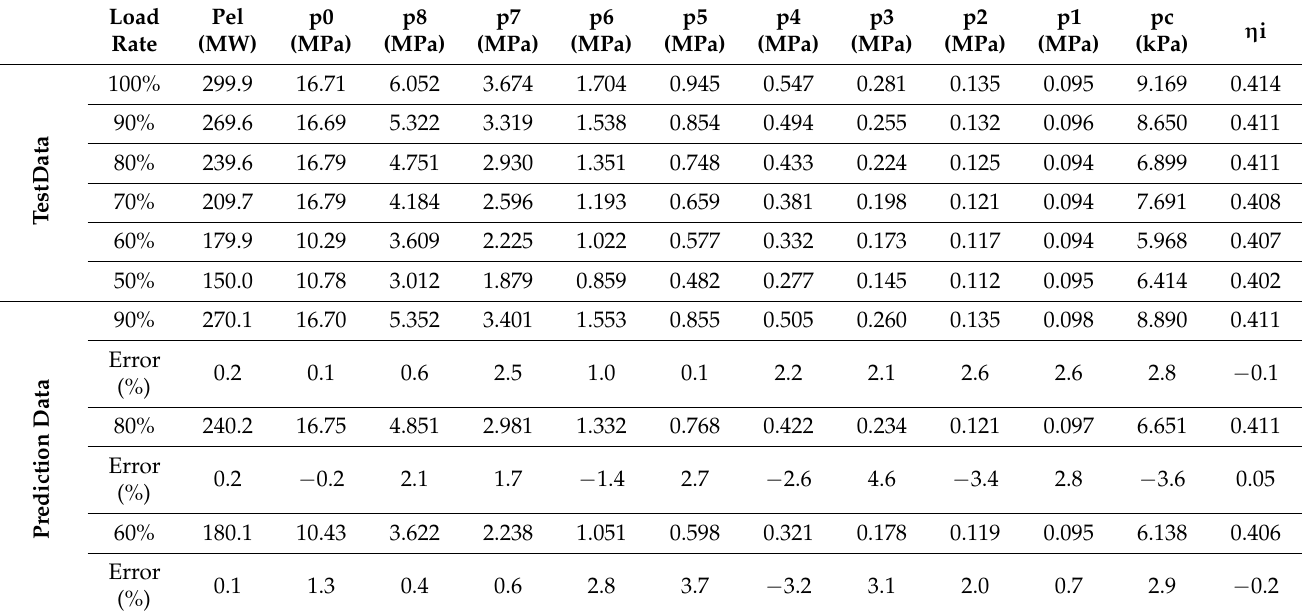
Table 3. Performance prediction model